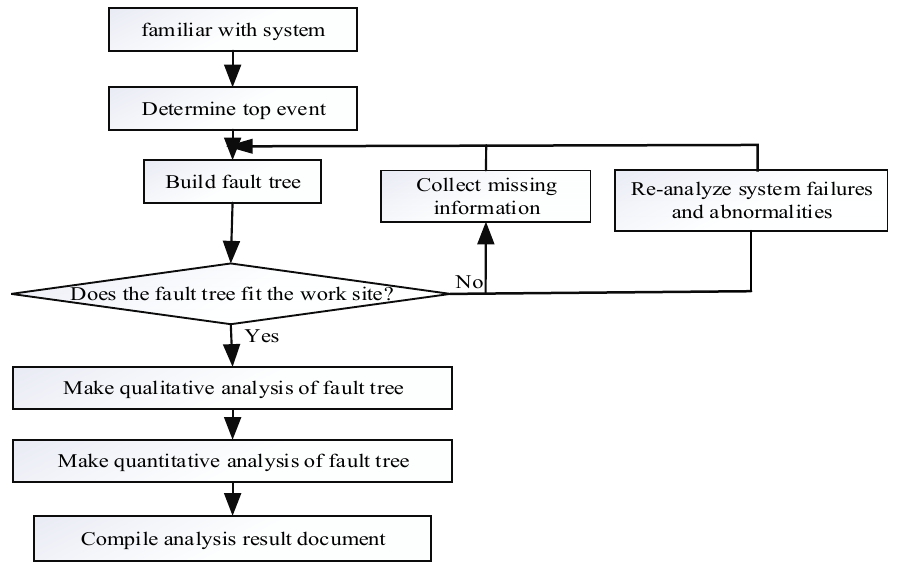
Figure 1. Workflow of the FTA